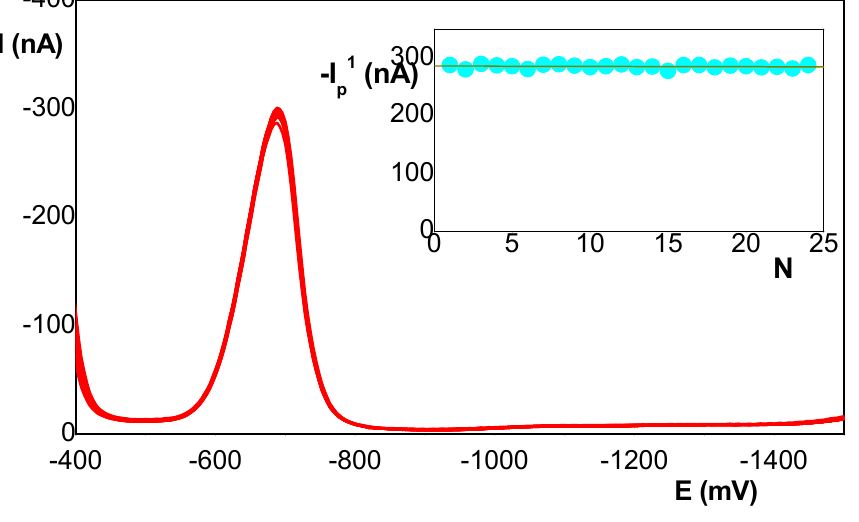
Figure 3. Repeatability of differential pulse voltammograms at m-AgSAE of 3-nitrofluoranthene (c = 100 µmol L -1 ) in MeOH-0.01 mol L -1 NaOH (9:1) mixed medium. Inset shows the dependence of the peak current on the number of measurements N. E